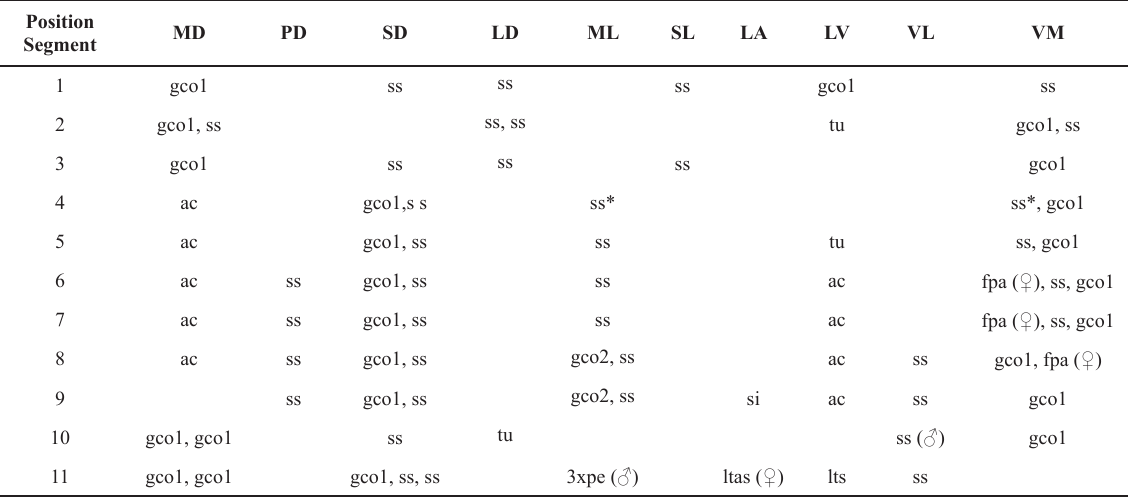
Table 12. Summary of nature and location of sensory spots, glandular cell outlets, tubes and spines arranged by series in Echinoderes sensibilis Adrianov et al .,